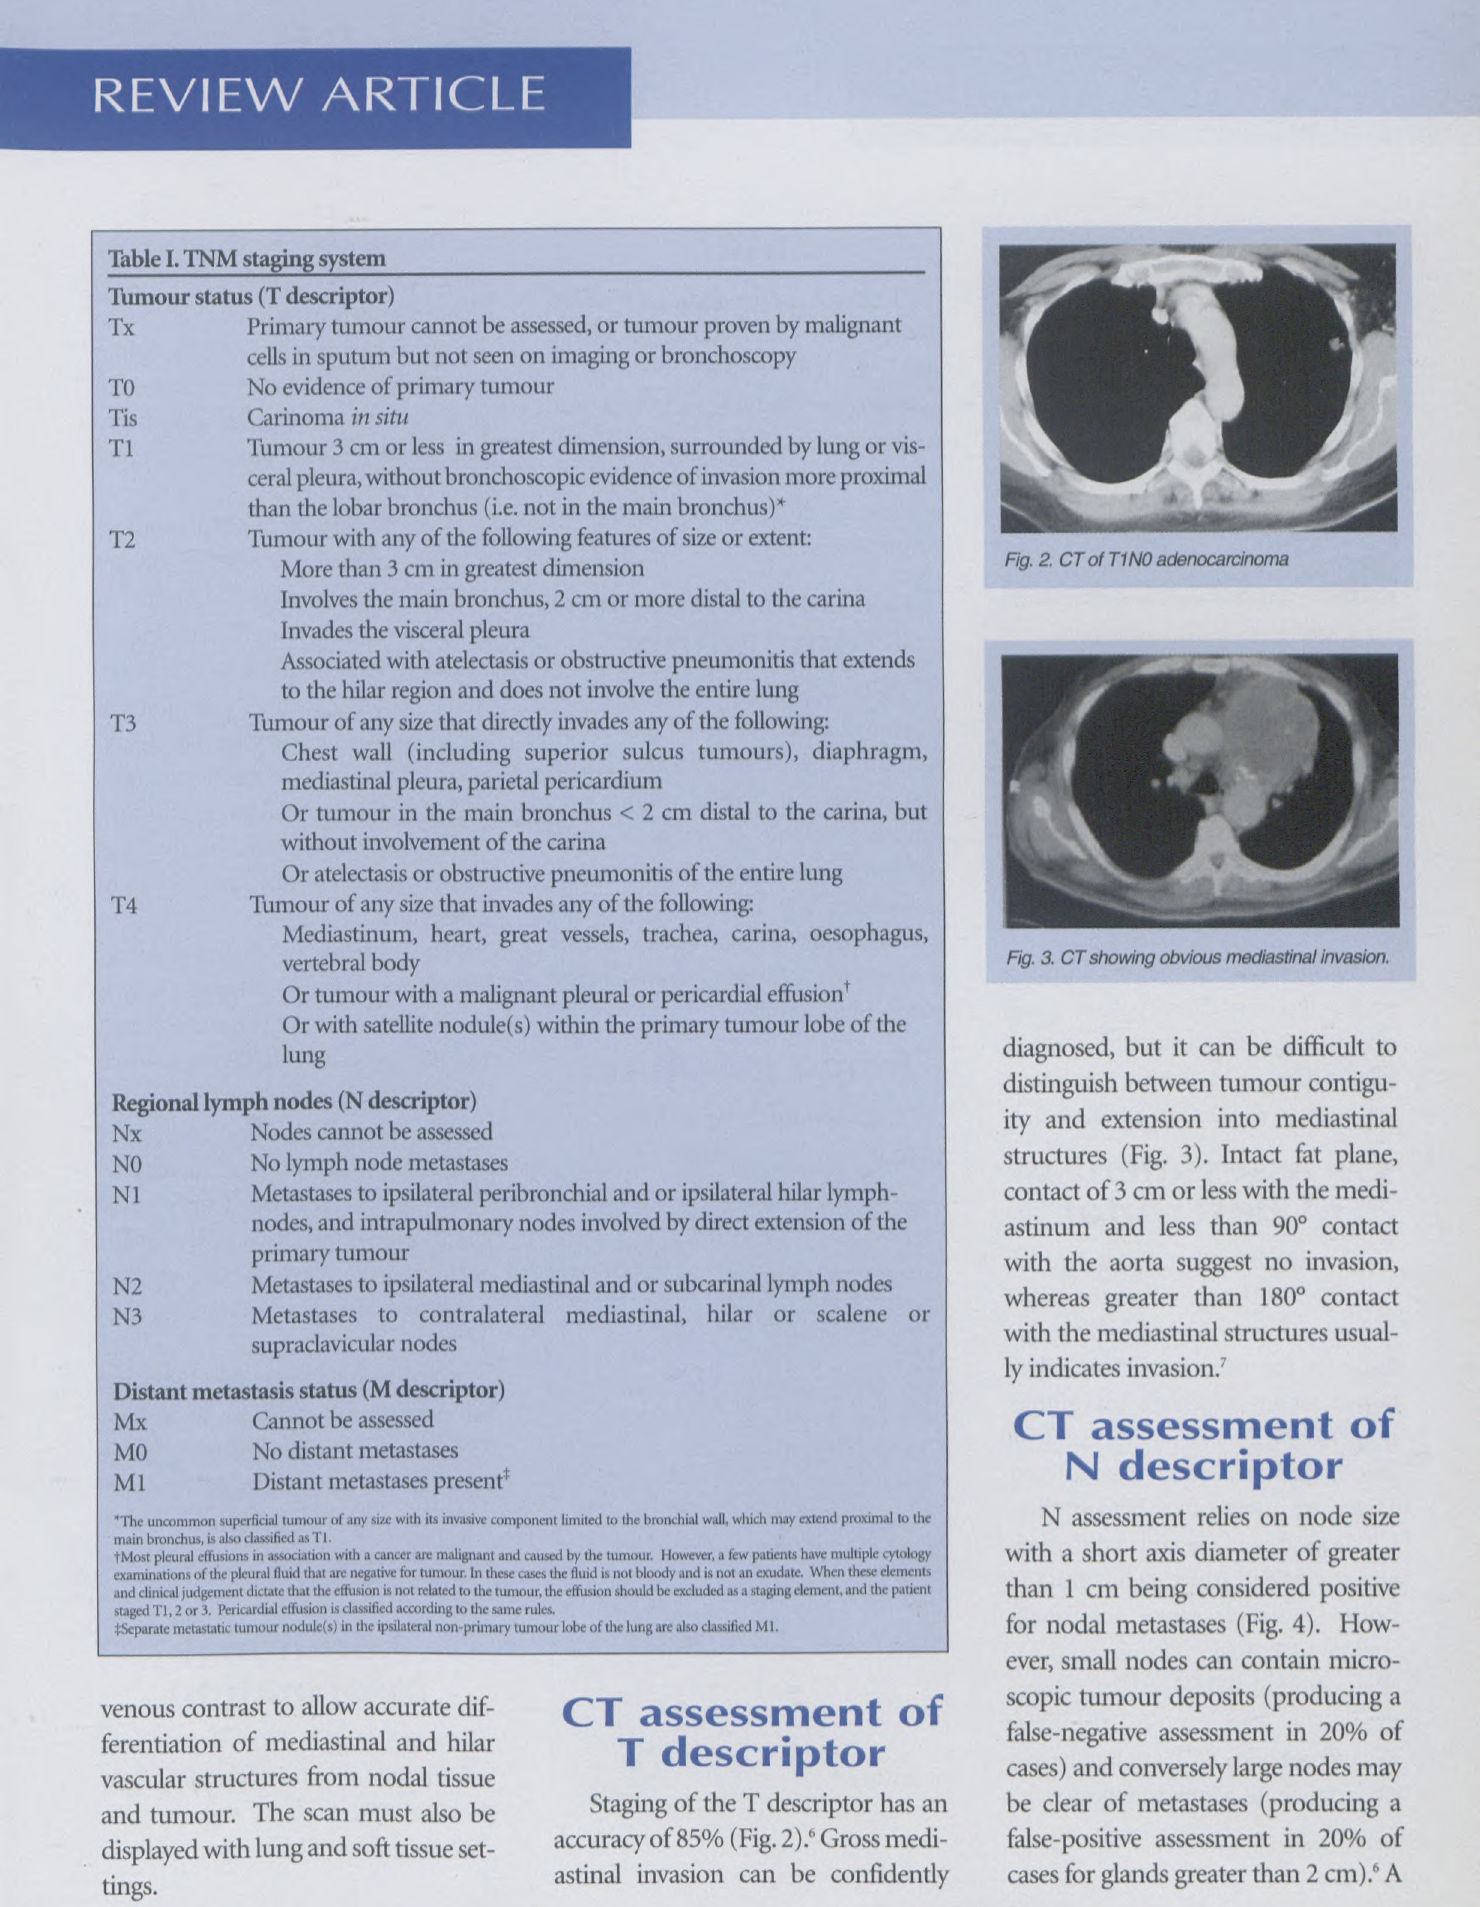
Table I. TNM staging system